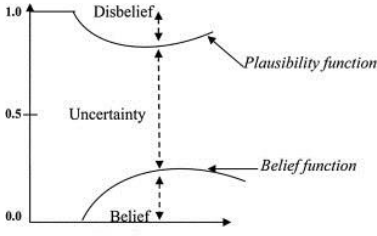
Figure 3. Evidential theory function’s relationships